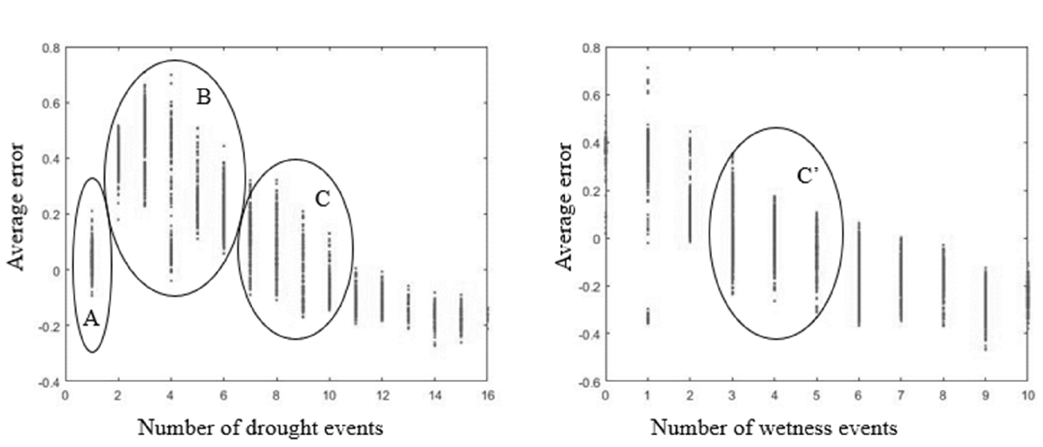
Figure 6. Results of experimental plan: average error depending on the number of drought and excess of water events. Three panels identified as examples. A: only one event for calibration; B: between two and six events; C and C’: best distribution of average error.